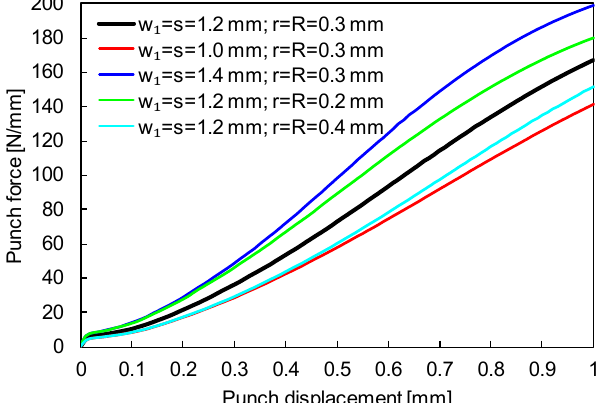
Figure 14. Punch force evolution obtained for three values of channel / rib width and three values of punch / die fillet radius (plane strain conditions).